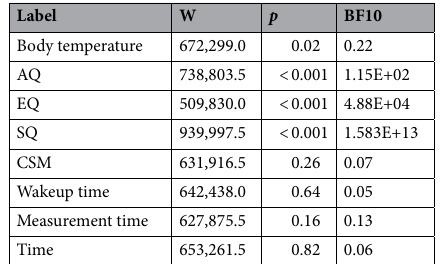
Table 8. Results for the comparisons between sexes in Survey